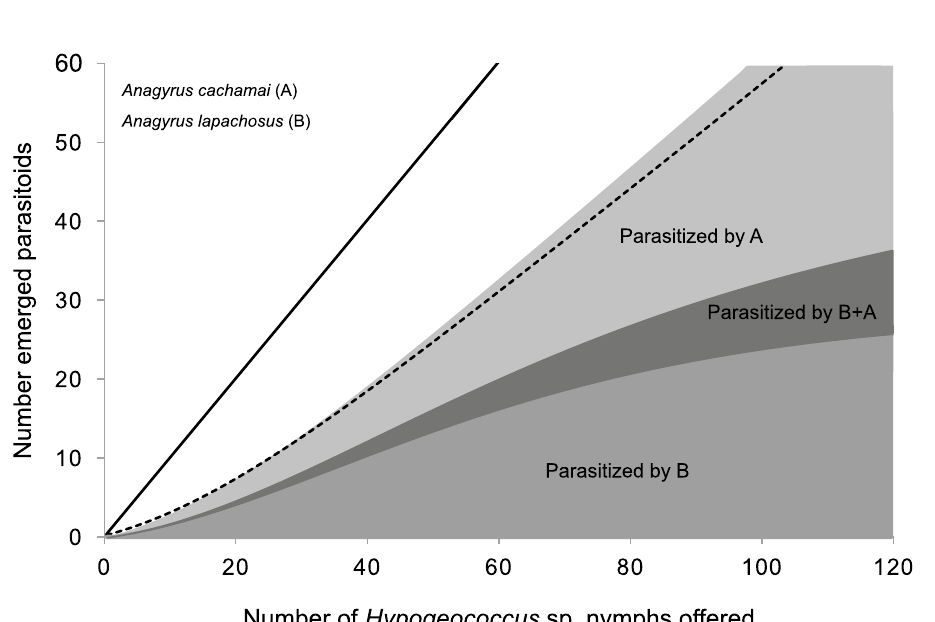
Figure 5. Expected functional response in the interaction between the parasitoids Anagyrus cachamai ( A ) and A. lapachosus ( B ), when the nymphs of Hypogeococcus sp. were first exposed to A. lapachosus . Black line: number of nymphs offered is equal to the number of nymphs attacked by parasitoids. Dotted line: females of A. cachamai do not have a host selection behavior; therefore, the number of nymphs attacked is at